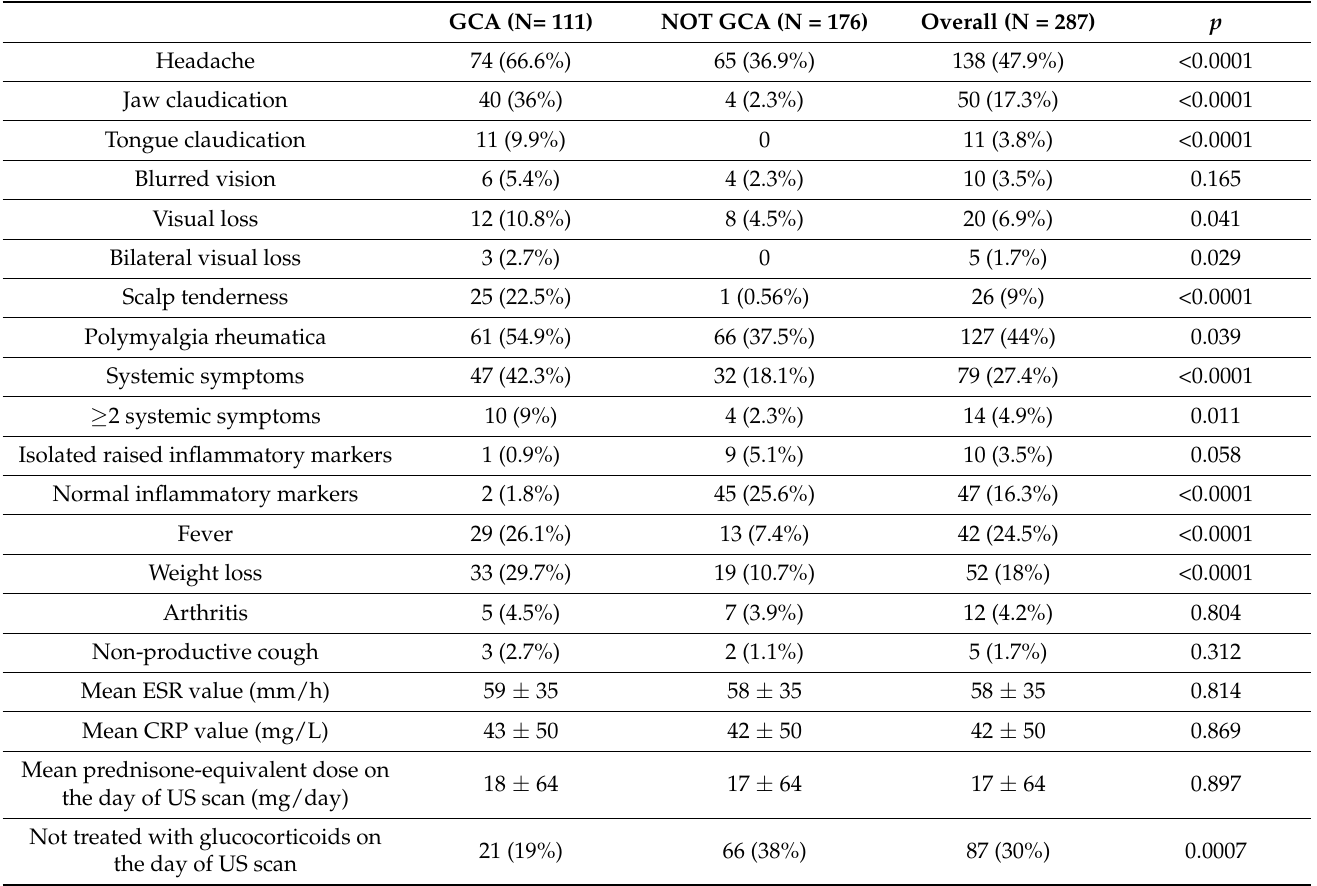
Table 1. Clinical presentation of newly referred patients to the fast-track